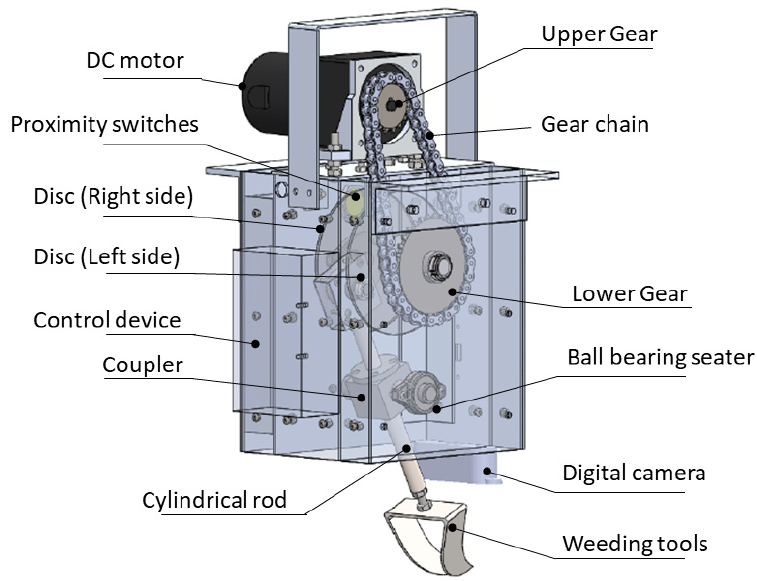
Figure 2. A drawing prototype of the weeding mechanism. Table 1. The specifications of the weeding machine.